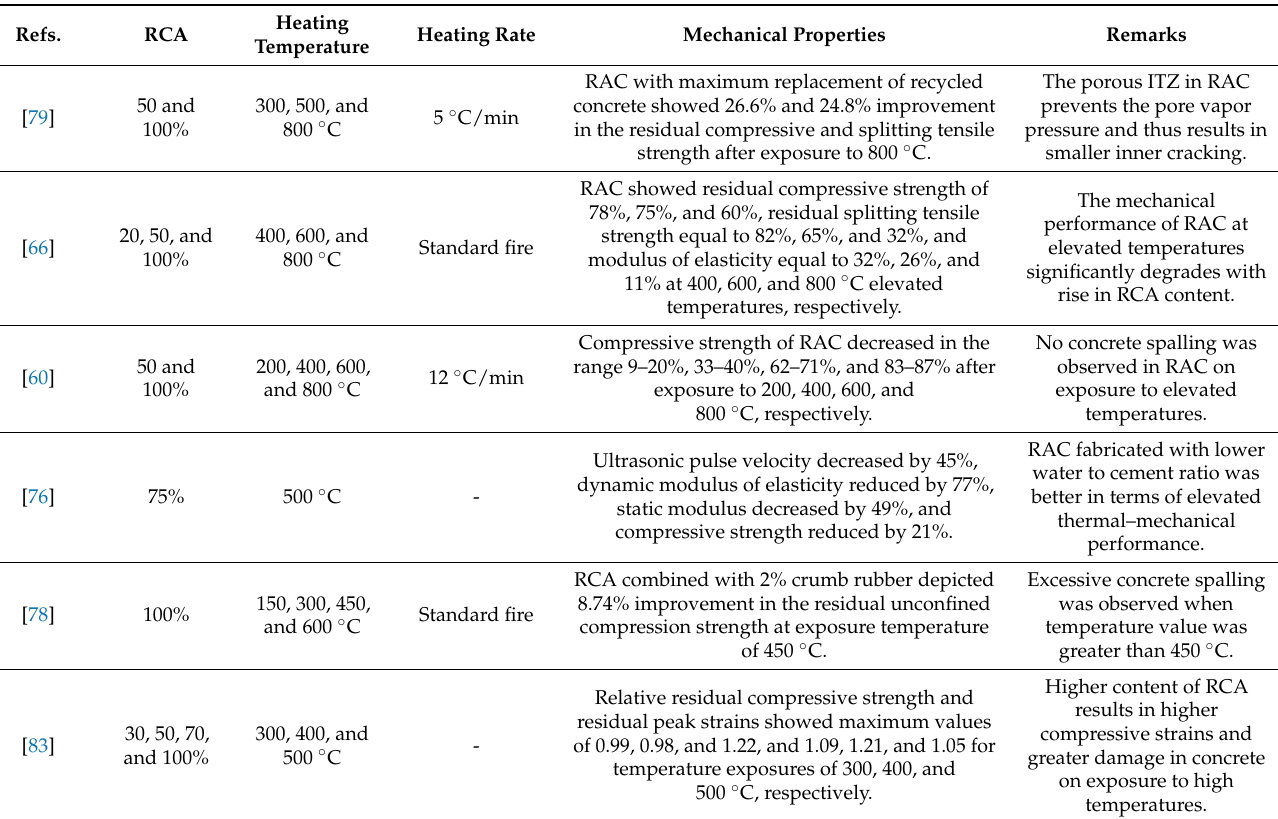
Figure 7. Relative modulus of elasticity of RAC with varying elevated temperature and proportions of RCA [50,60,66,75,139]. Table 2. Residual properties of RAC at various temperature conditions and replacement percentages of recycled aggregate.